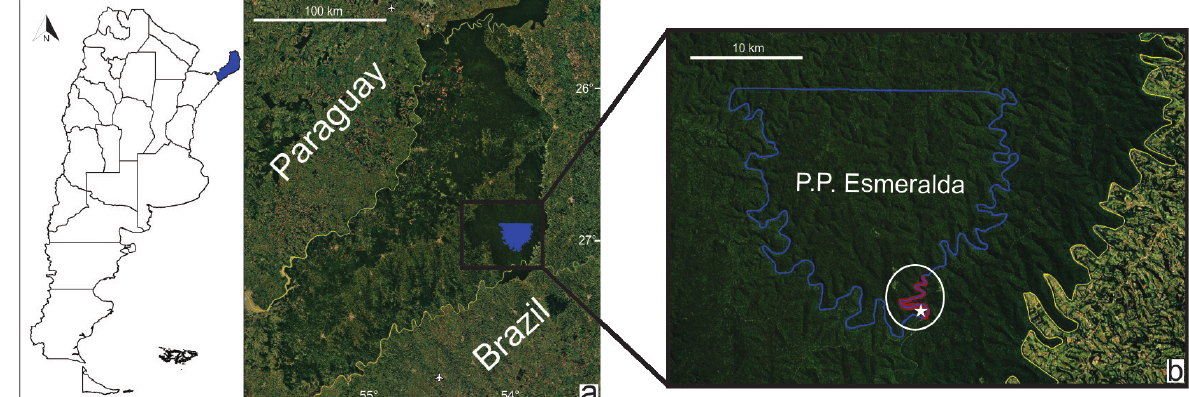
Figure 1. Study area. a. Black square = Yabotí Biosphere Reserve; b. Detail of Esmeralda Provincial Park, surveyed area of the Yabotí-miní river colored in red within white circle. The star indicates the type